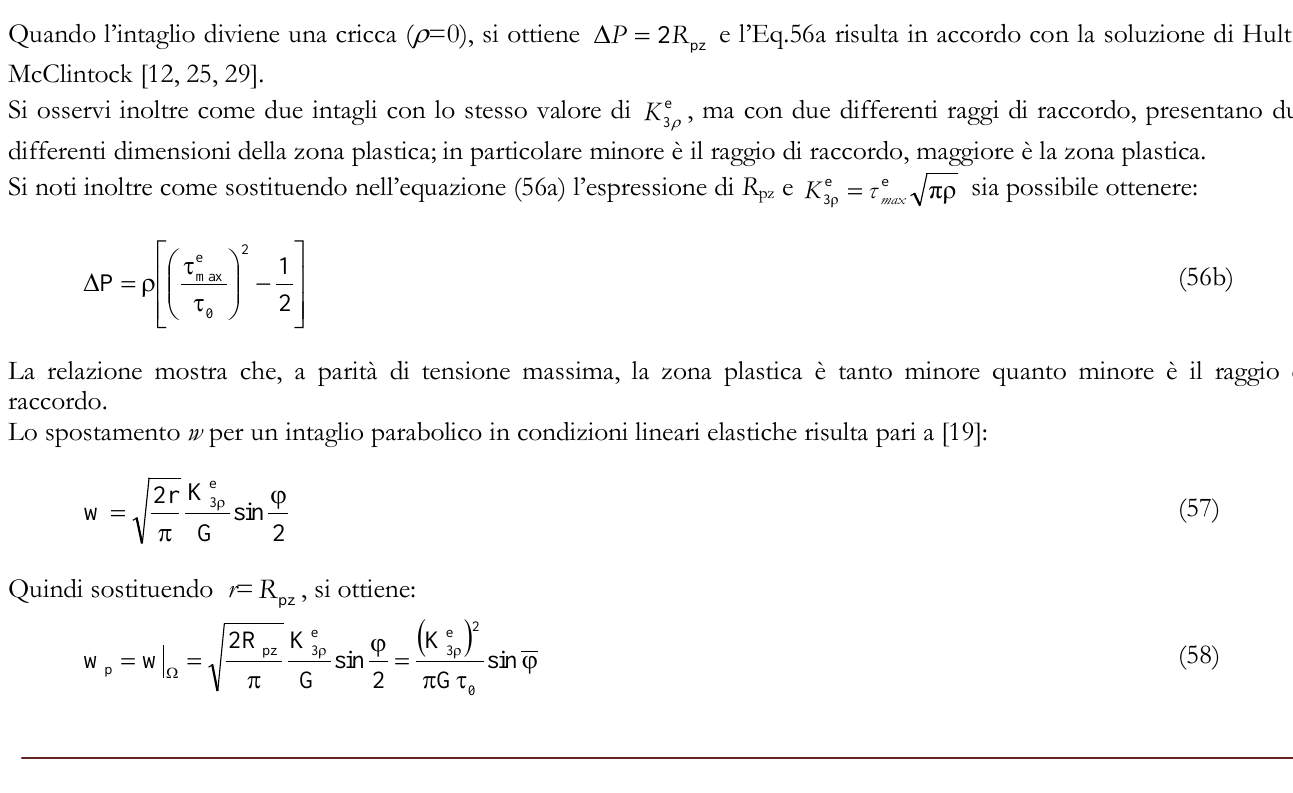
Figura 12: Confronto tra la zona plastica approssimata (a), basata sulla soluzione lineare elastica, e la zona plastica esatta (b) per un materiale a comportamento elastico perfettamente